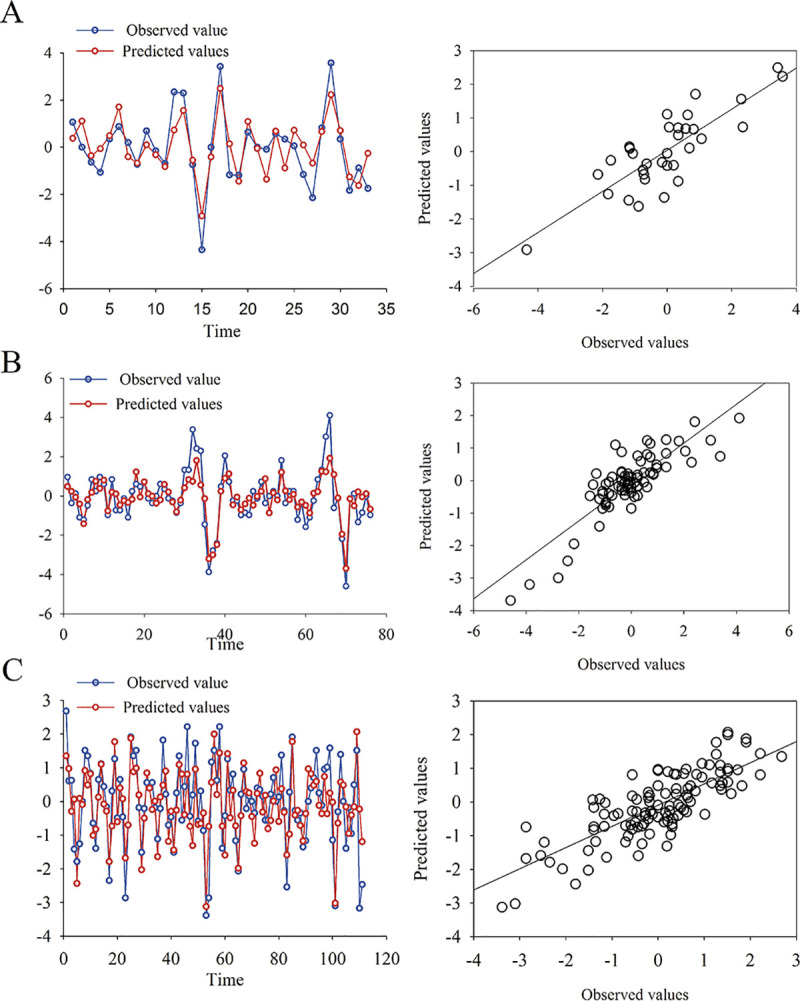
Plots of observed and fitted hantavirus infections.Observed values versus the predicted by the selected model for hantavirus infections in northwestern Argentina. (A) Biannual data arrangement with rainfall (t-1) and temperature (t-1) as explanatory variables. (B) Quarterly data arrangement with rainfall (t-1) and temperature (t-2) as explanatory variables. (C) Bimestrial data arrangement with rainfall (t-1, t-2) and temperature (t-1, t-2) as explanatory variables.